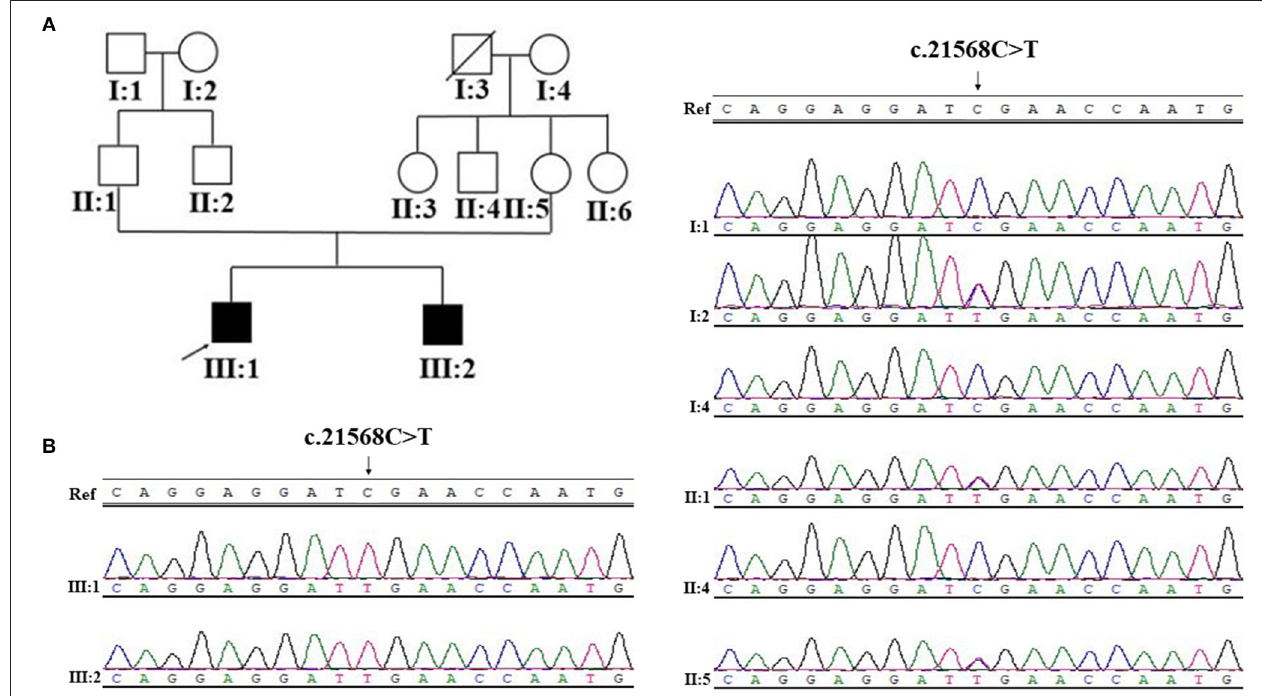
FIGURE 1 | Pedigree structure, and Sanger sequencing of SYNE1 variant (c.21568C > T) of Family 1. (A) Pedigree structure. (B) Segregation of SYNE1 variant identified in subjects of Family 1, whose DNA sample were available. Ref: reference sequence in NCBI.